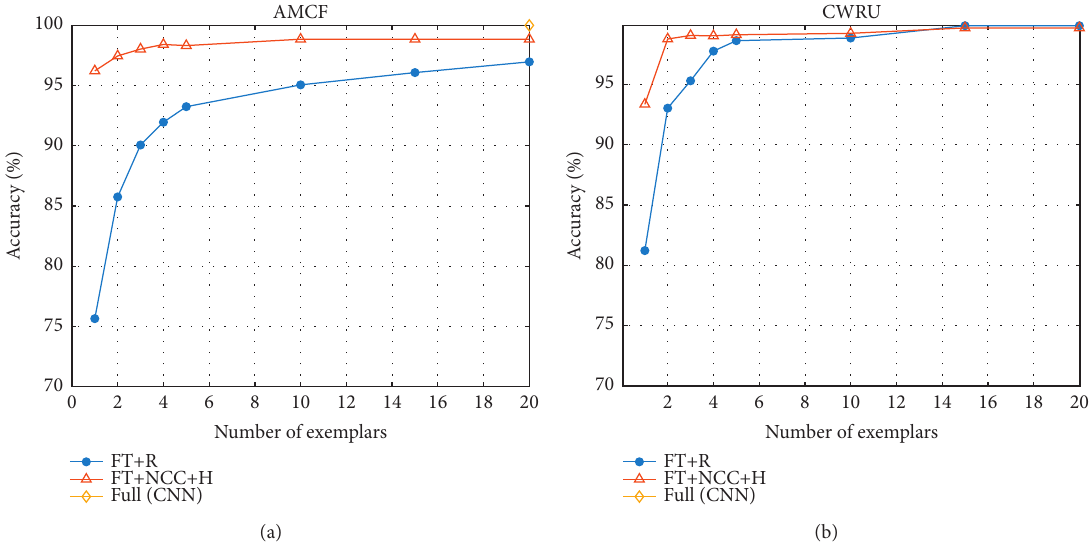
Figure 5: Impact of the number of exemplars stored in memory: (a) AMCF and (b) CWRU.